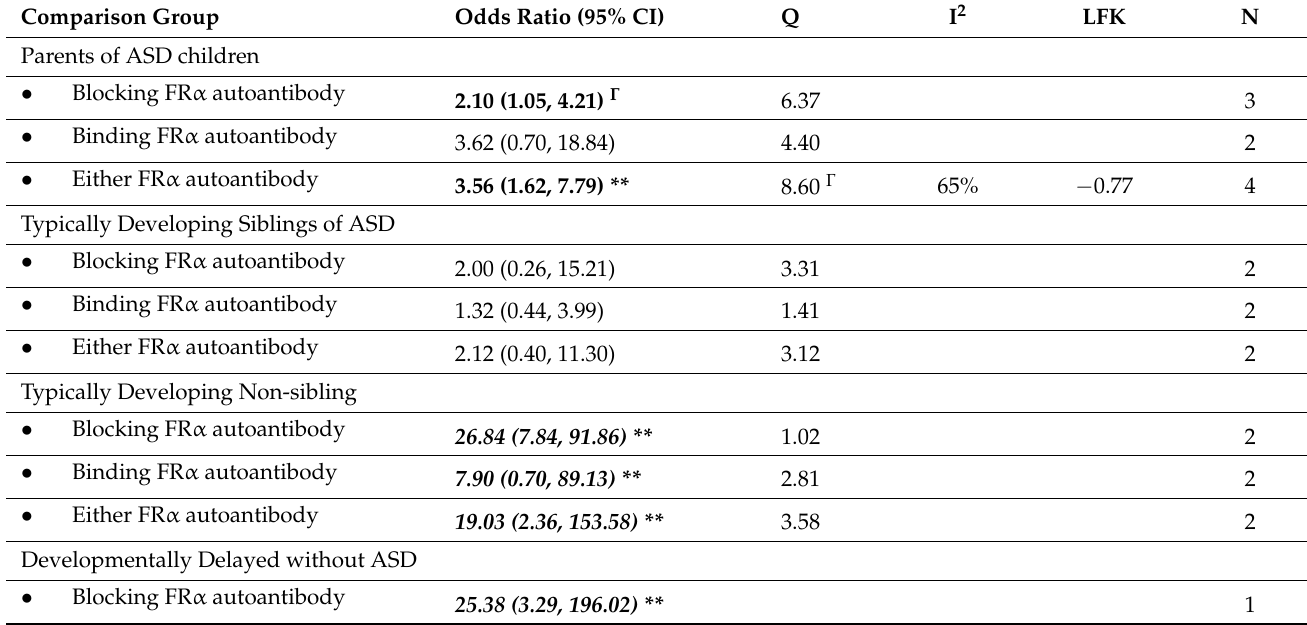
Table 2. Meta-analysis of Odds Ratios with 95% confidence interval for differences between the prevalence of Folate Receptor Alpha Autoantibodies in children with ASD to Various Comparison Groups. Odd ratios that are significant are bolded and italicized. Also listed are Cochran’s Q (Q), Heterogeneity Index (I2), Luis Furuya-Kanamori (LFK) Index and number of studies involved (N). Statistics are estimated by a random-effects model. Γ p < 0.05, ** p ≤ 0.001. Comparison Group Odds Ratio (95% CI) Q I 2 LFK N Parents of ASD